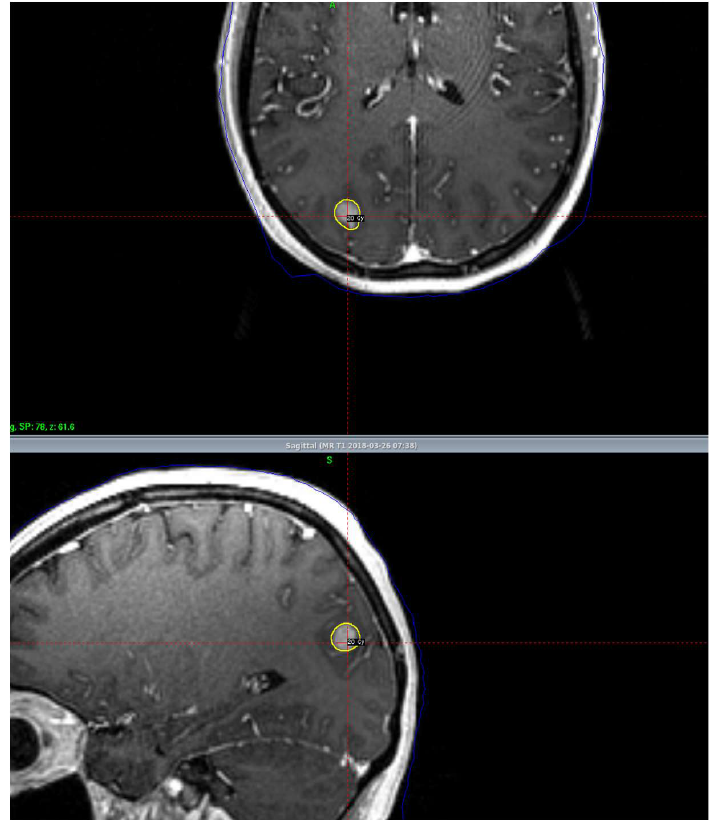
Figure 3. A radiation treatment plan in a patient with a brain metastasis receiving stereotactic radiosurgery to a dose of 20 Gy prescribed to the tumor margin. This patient maintained local control of their disease at one year.